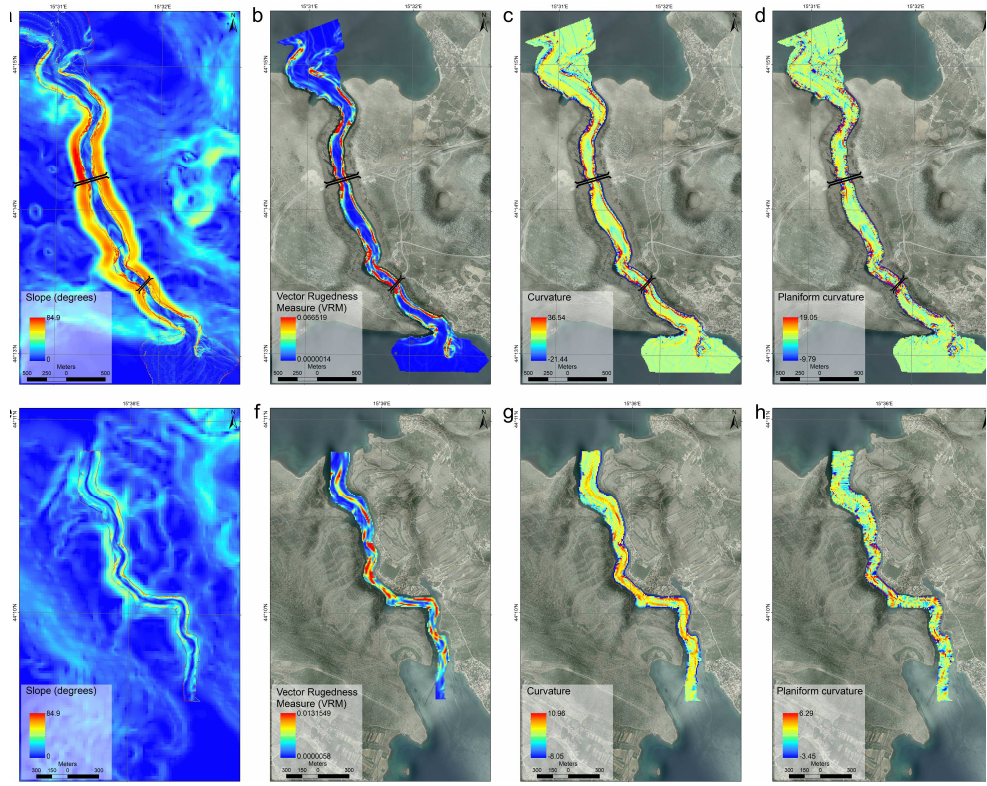
Figure 4. ( a ) Slope analysis of NZD and its surroundings. ( b ) Vector ruggedness measure of NZD. ( c ) Curvature analysis of the NZD area. ( d ) Planiform curvature calculated for the NZD area; the two bridges across NZD are illustrated as references. ( e ) Slope analysis of KZD and its surroundings. ( f ) Vector ruggedness measure of the KZD. ( g ) Curvature analysis of the KZD area. ( h ) Planiform curvature calculated for the KZD